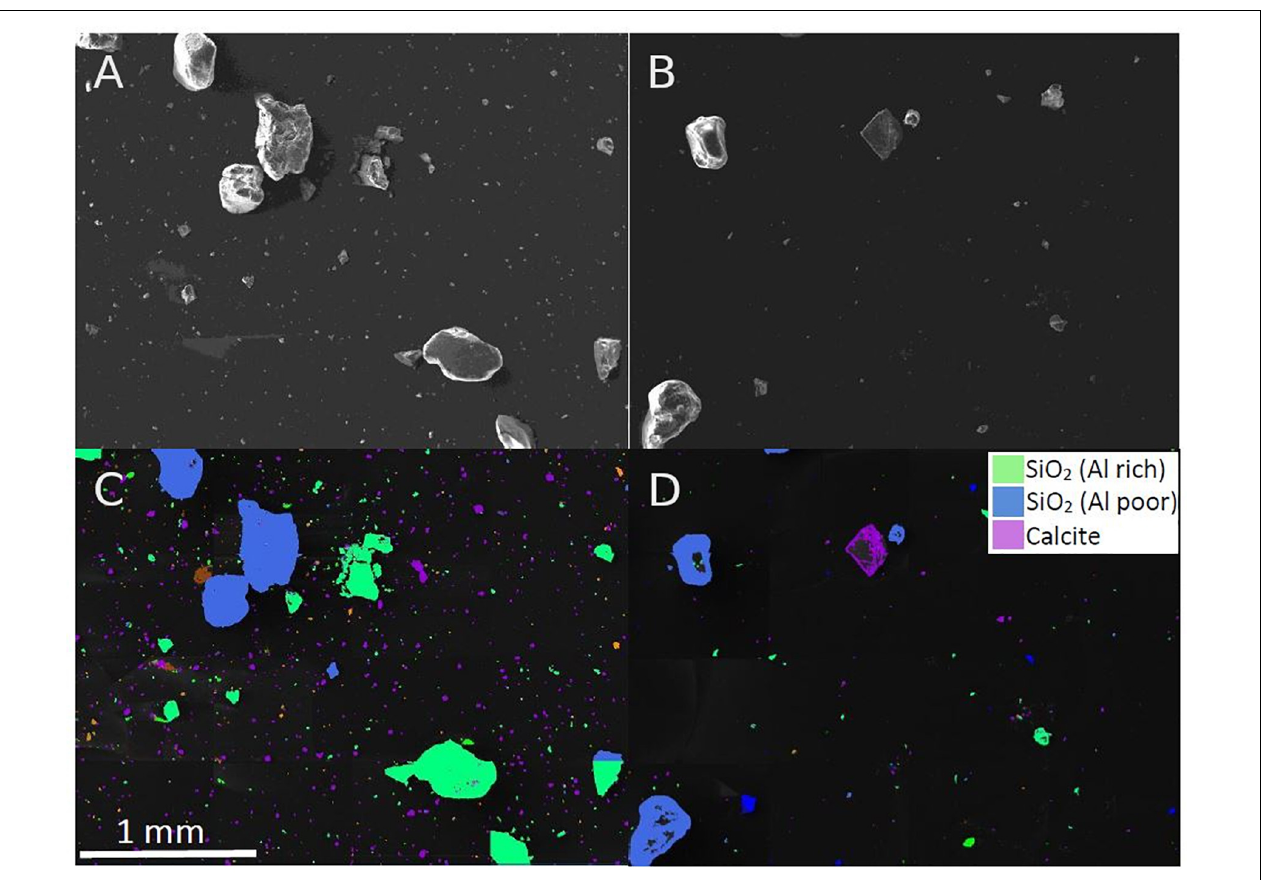
FIGURE 2 | SEM images of (A) commercial sand and (B) beach sand. Mineral classification of sediment particles for (C) commercial sand and (D) beach sand. High amounts of small calcite particles can be seen in the commercial sand samples (purple in C ), which are largely absent in the beach sand sample (D) .